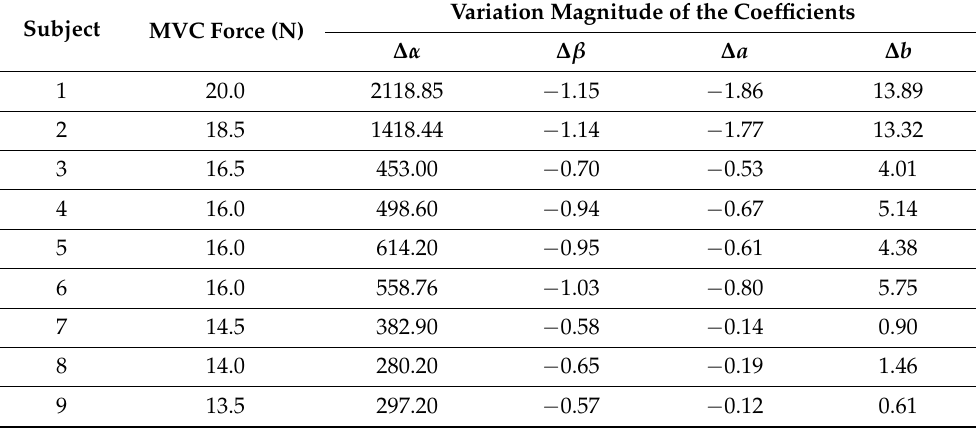
Table 3. Variation magnitudes of a , b , α , and β during the fatigue